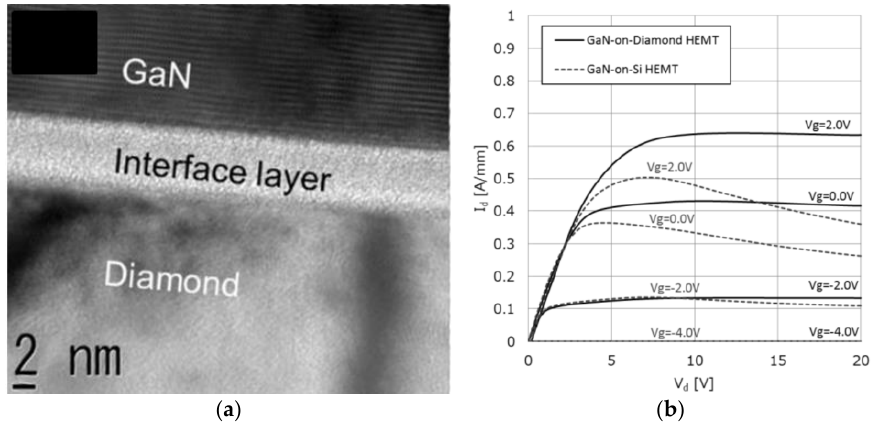
Figure 9. ( a ) Cross-section TEM image of GaN/diamond interface obtained by SAB. ( b ) I D - V D char- acteristics of GaN-on-Si (dashed lines) and GaN/diamond (solid lines) HEMTs (reprinted from [114], Copyright 2019 The Japan Society of Applied Physics).